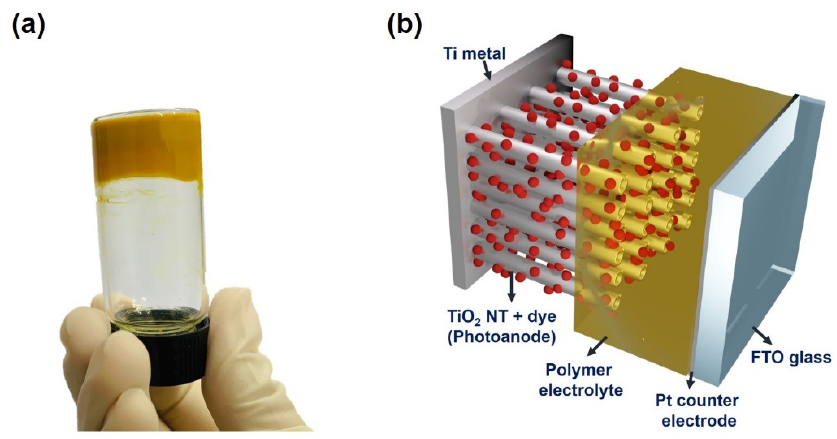
Figure 3. ( a ) Photograph of PEO-based polymer electrolyte in a glass vial, and ( b ) schematic device structure of the quasi-solid-state dye-sensitized solar cells (DSSC) employing an anodic TiO 2 NT electrode.